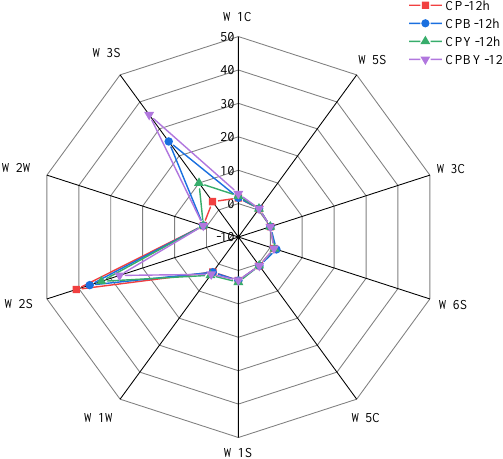
Figure 4. Radar plot of four groups of fermented specimens. CP-0 h, unfermented chickpea milk; CPB-0 h, unfermented chickpea milk with papain treatment; CPY-0 h, unfermented chickpea milk with yam addition; CPBY-0 h, unfermented chickpea milk with papain treatment plus yam addition.